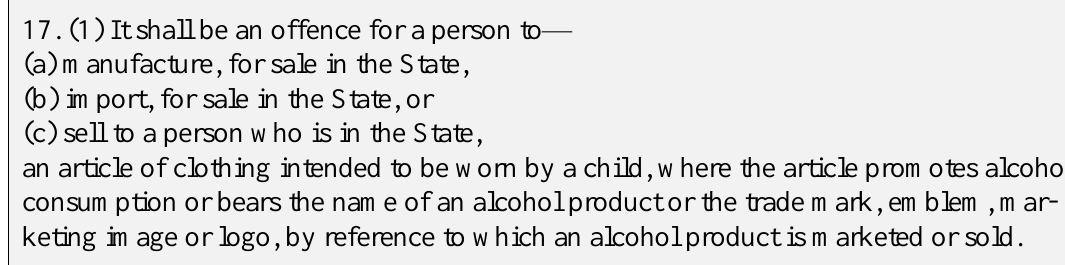
Table 1. Section 17 of Ireland’s Public Health (Alcohol) Act